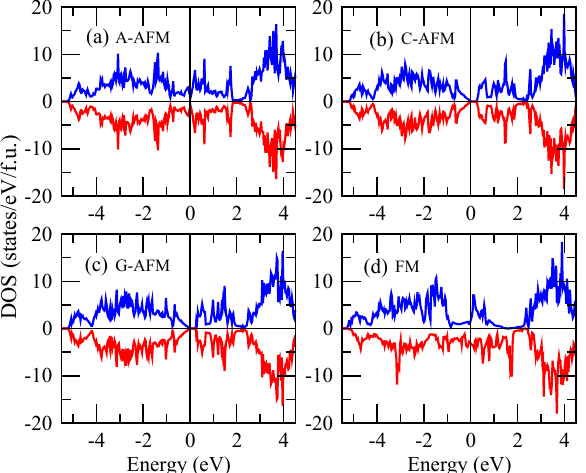
Figure 3. Calculated density of states of ThMnPN for the ( a ) A-AFM, ( b ) C-AFM, ( c ) G-AFM, and ( d ) FM spin arrangements. Up-spin and down-spin density of states are indicated by blue and red lines, respectively. The Fermi level is denoted by a vertical black line at E = 0